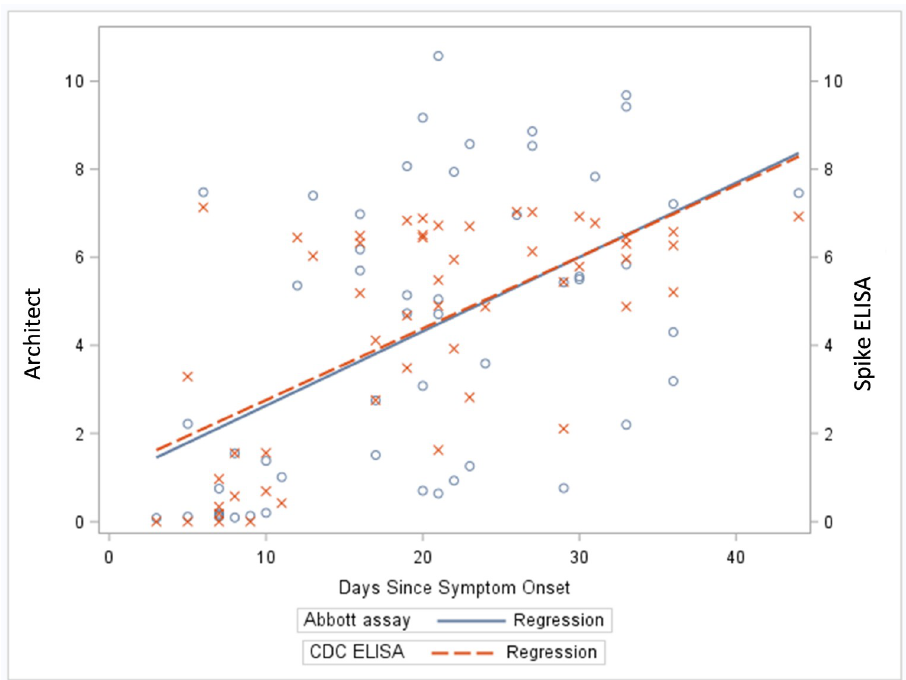
Fig 2. Comparison of SARS-CoV-2 spike protein ELISA (spike ELISA) and Abbott Architect TM SARS-CoV-2 IgG assay using serum samples from individuals with a positive rRT-PCR test result (n = 52) by days since symptom onset. � Each blue circle (O) represents a serum sample tested by the Architect assay; each red cross (X) represents a serum sample tested by the Spike ELISA. Samples collected from asymptomatic individuals (n = 4) were excluded from the